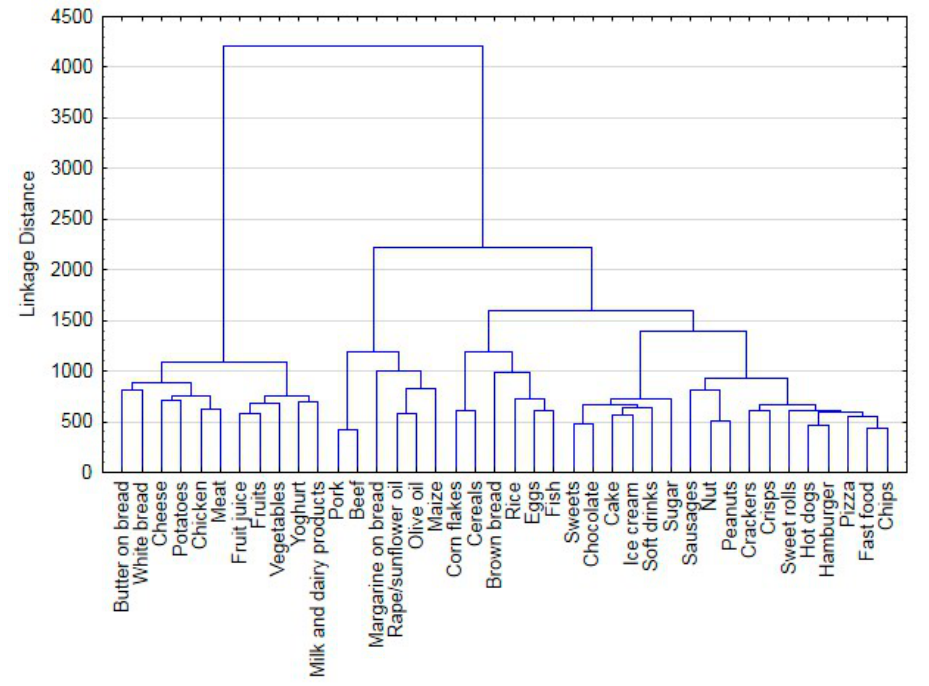
Figure A1. Tree diagram for cluster analysis of personal dietary assessment. Ward’s method was used. The Manhattan distances were used for measuring.